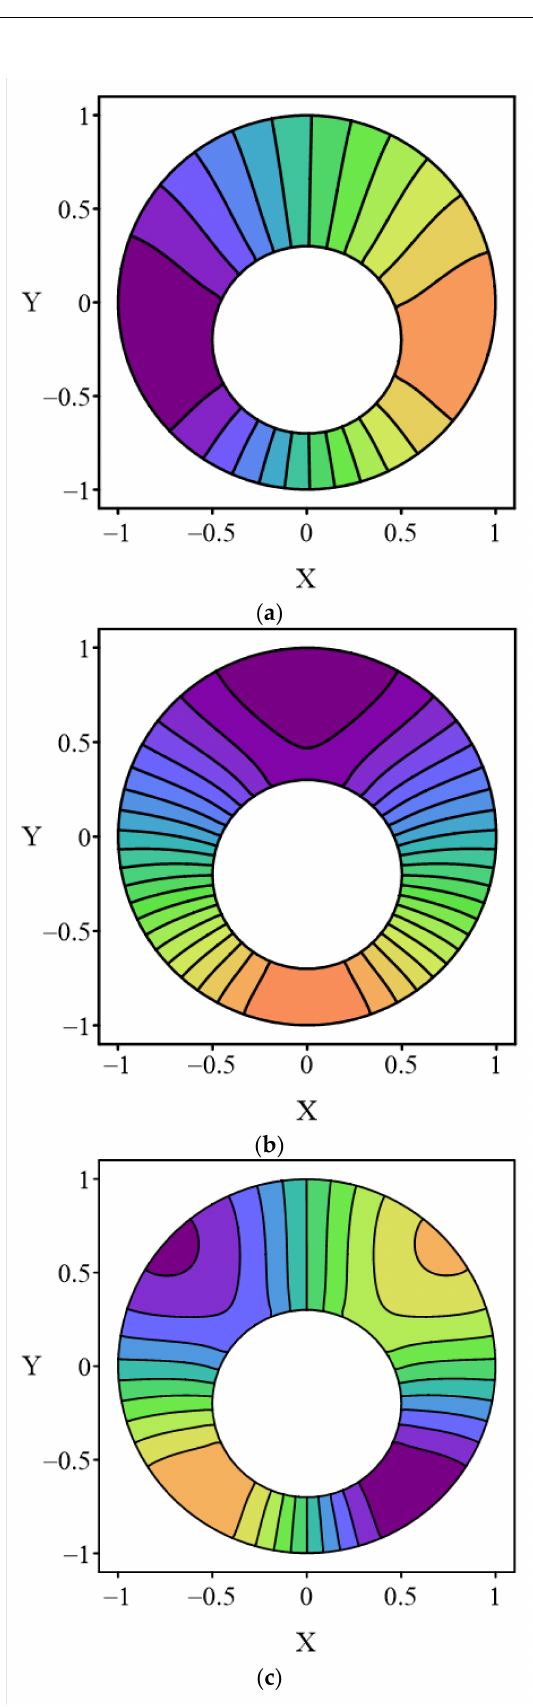
Figure 11. The first three eigenmodes for the eccentric annular waveguide (TE wave): ( a ) k 1 = 1.3522, ( b ) k 2 = 1.4079, and ( c ) k 3 =